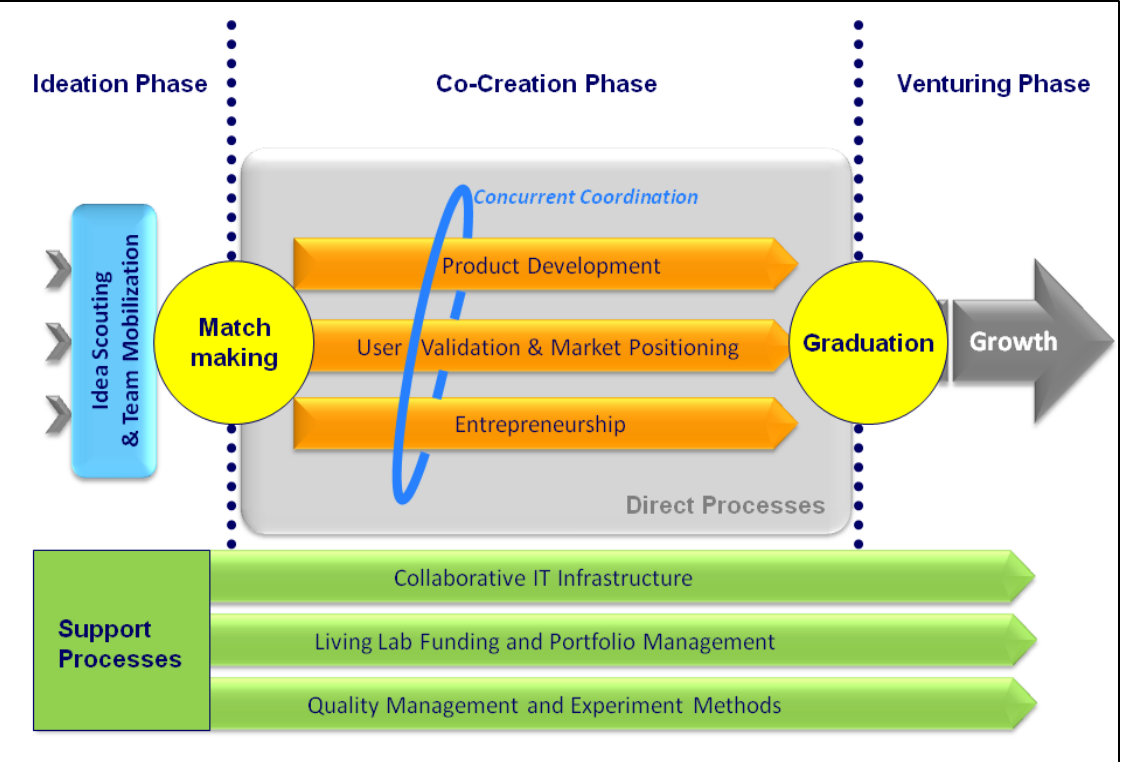
Figure 2: Innovation processes of a Living Lab (Katzy,